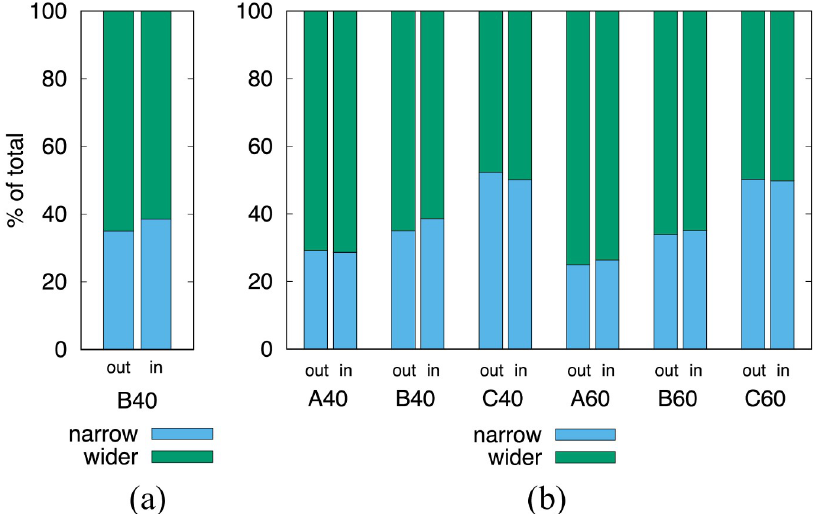
Fig 3. Percentage split of RBCs as they enter the daughter branches. (a) The out column shows the situation when the rare cell is in the parent channel and the in column when the rare cell is in the daughter channel. (b) Comparison of geometries and hematocrits. In the C cases, where both daughter branches have equal width, the one reported as wider is the one the rare cell